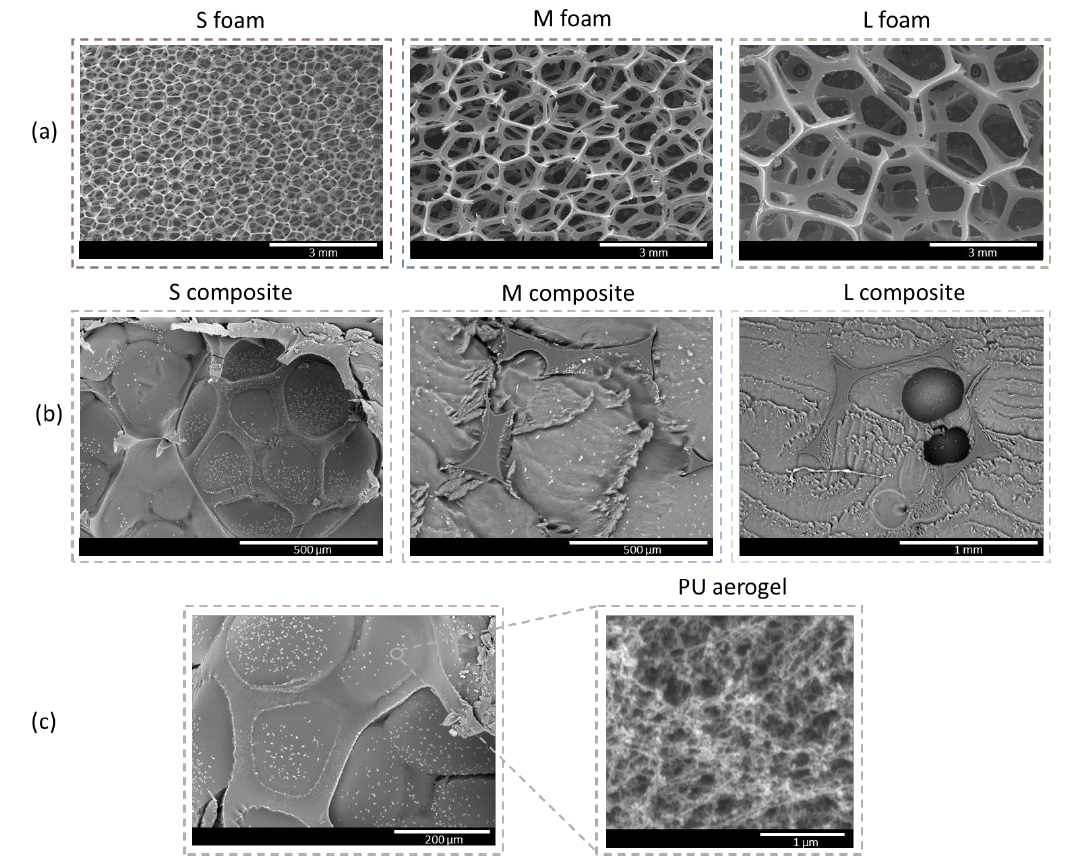
Figure 4. ( a ) Cellular structures of the reticulated foams, ( b ) morphology of the PU F – PU A composites, ( c ) polyurethane aerogel contained inside the foam pores.